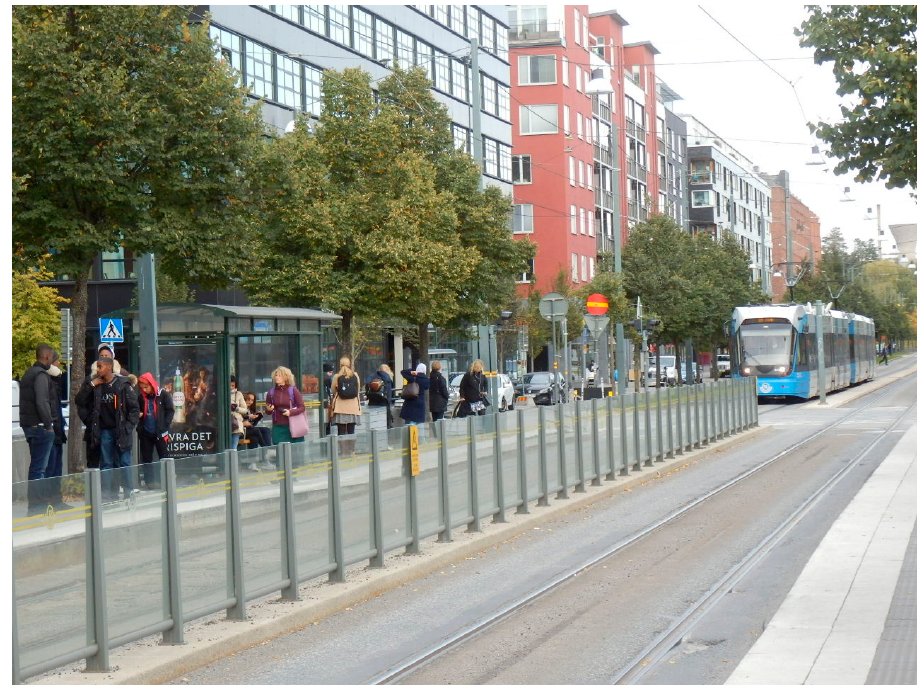
Figure 28. The new Hammarby Sjöstad walkable neighbourhood in Stockholm built around a tram service. Source: Jeffrey Kenworthy.